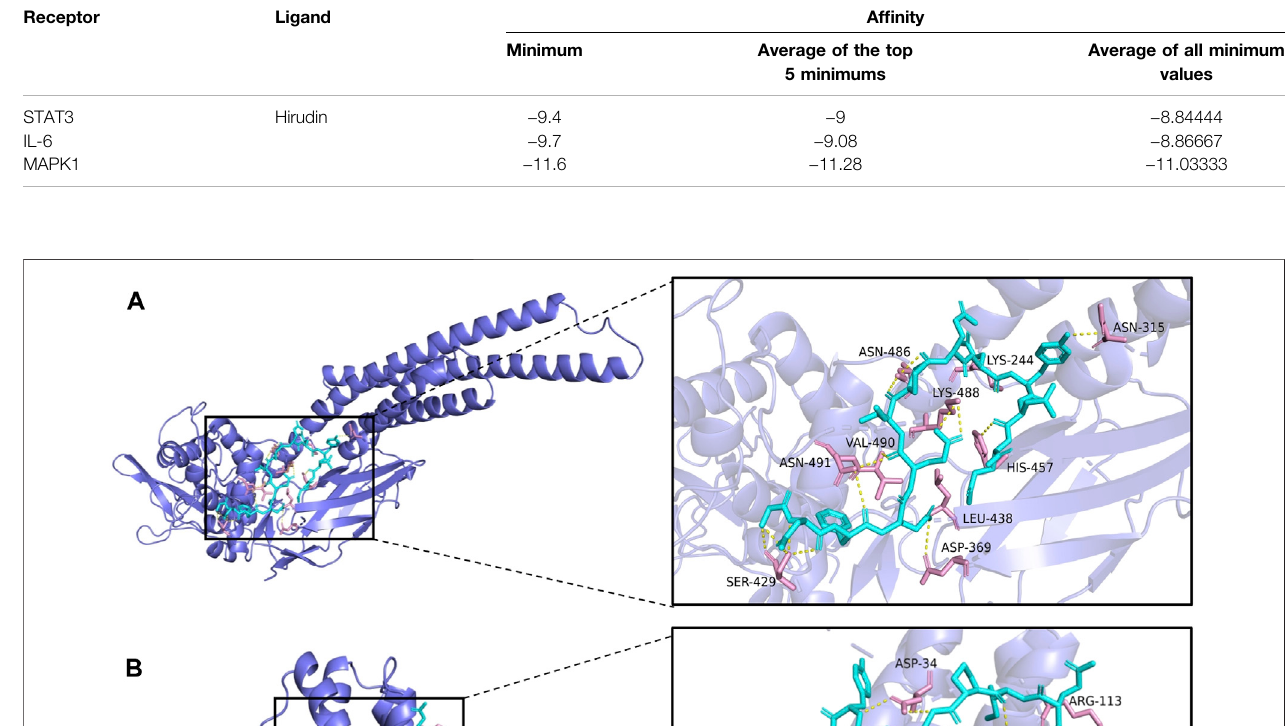
Frontiers in Pharmacology |